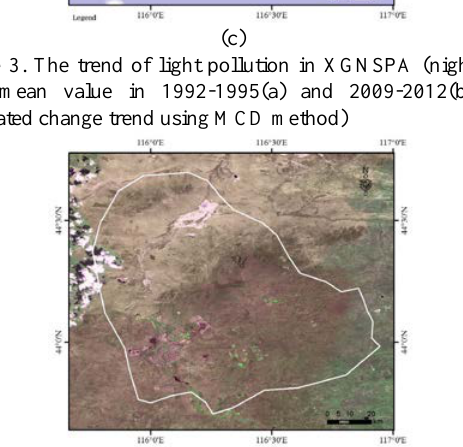
Figure 4. The GF-1 WFV image of